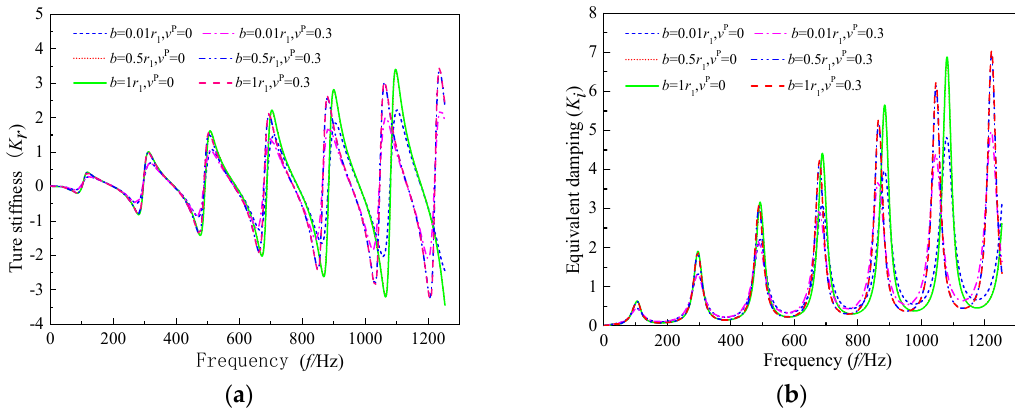
Figure 9. The effect of the radius of weakened soil due to a construction disturbance on the Figure 9. The e ff ect of the radius of weakened soil due to a construction disturbance on the longitudinal longitudinal impedance of the pile shaft: ( a ) true stiffness; ( b ) equivalent damping. impedance of the pile shaft: ( a ) true sti ff ness; ( b ) equivalent